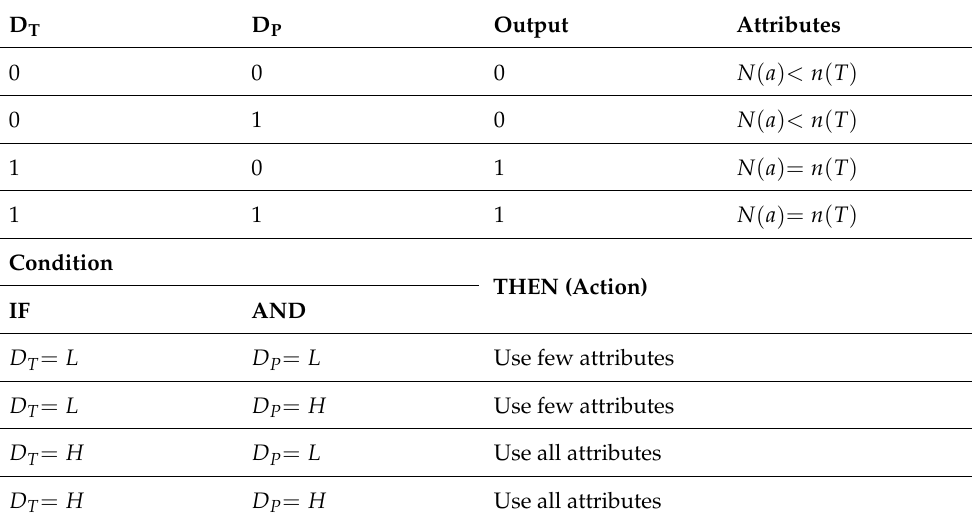
Table 1. Fuzzy input and